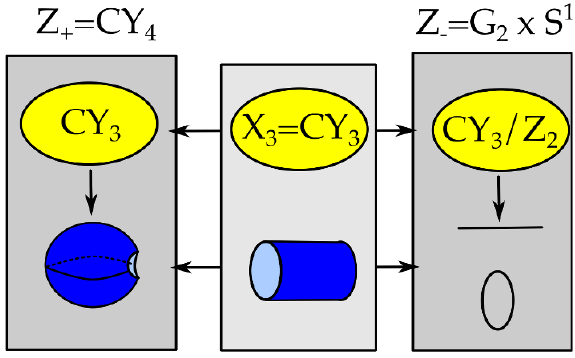
Figure 2 . The generalized connected sum (GCS) construction for Spin(7)-manifolds proposed in this paper: the left hand building block is an the acyl Calabi-Yau four-fold building block. We require this to be asymptotically approach a Calabi-Yau three-fold times a cylinder. One way to realize this is in terms of a CY 3 (cid:12)bration over an open P 1 . The right hand building block is a circle times a G 2 -manifold, which asymptotes to a CY 3 (cid:2) I times a circle. The simplest way to realize this is in terms of G 2 = (CY 3 (cid:2) R ) = Z 2 where Z 2 acts as an anti-holomorphic involution. The asymptotic region is CY 3 (cid:2)